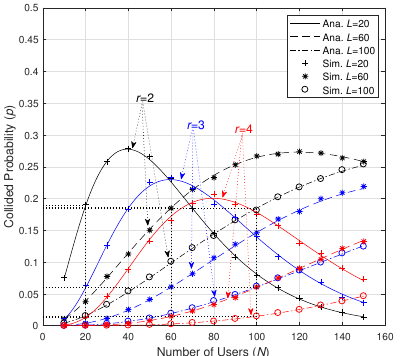
Figure 3. Collided probabilities when the number of packets transmitted in the same slot ( r ) = 2,3,4